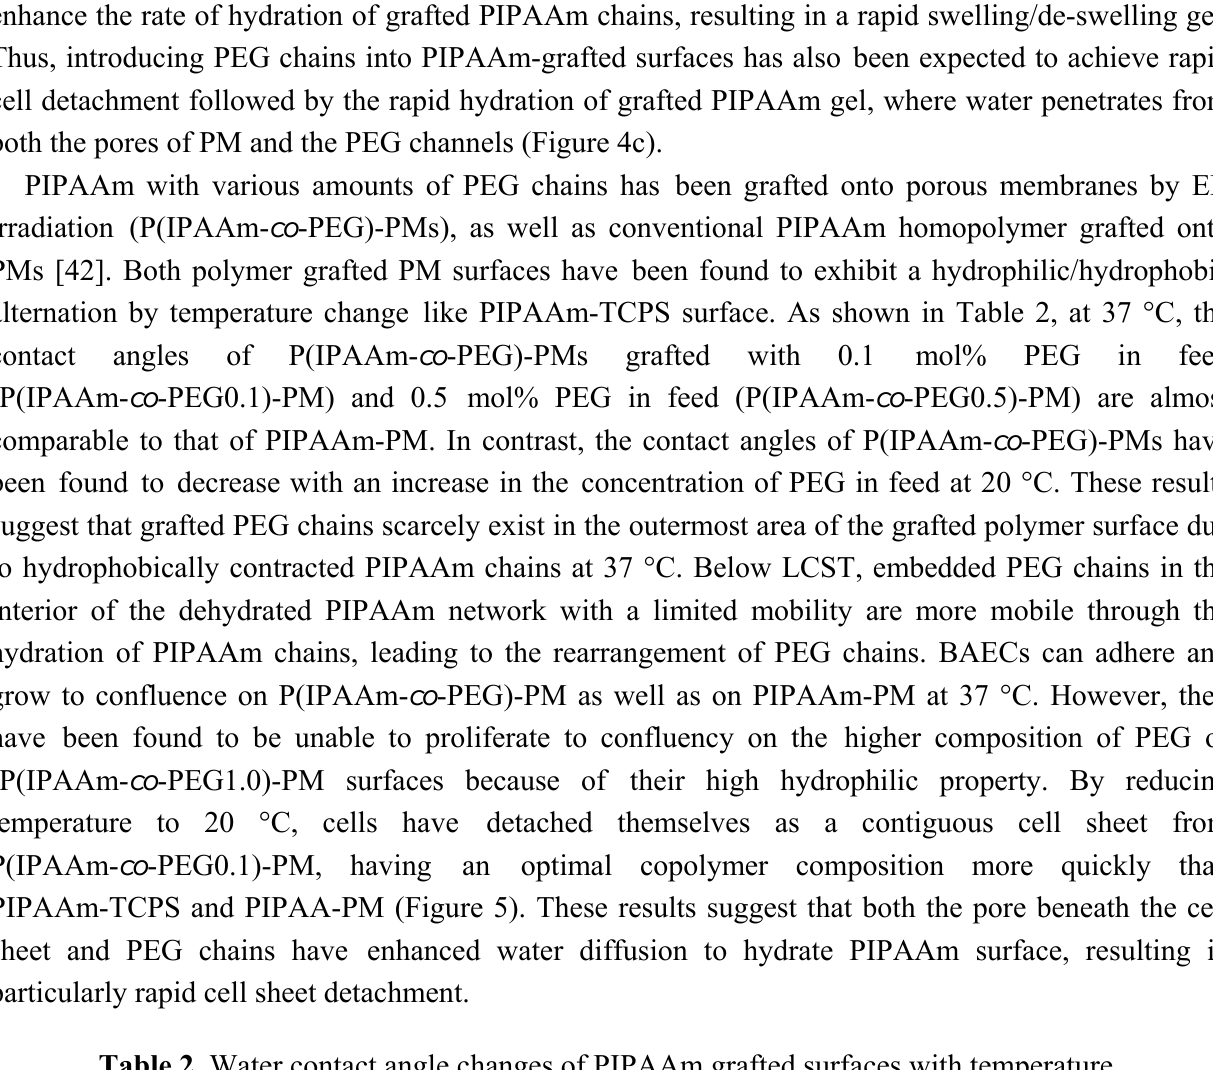
Table 2. Water contact angle changes of PIPAAm grafted surfaces with